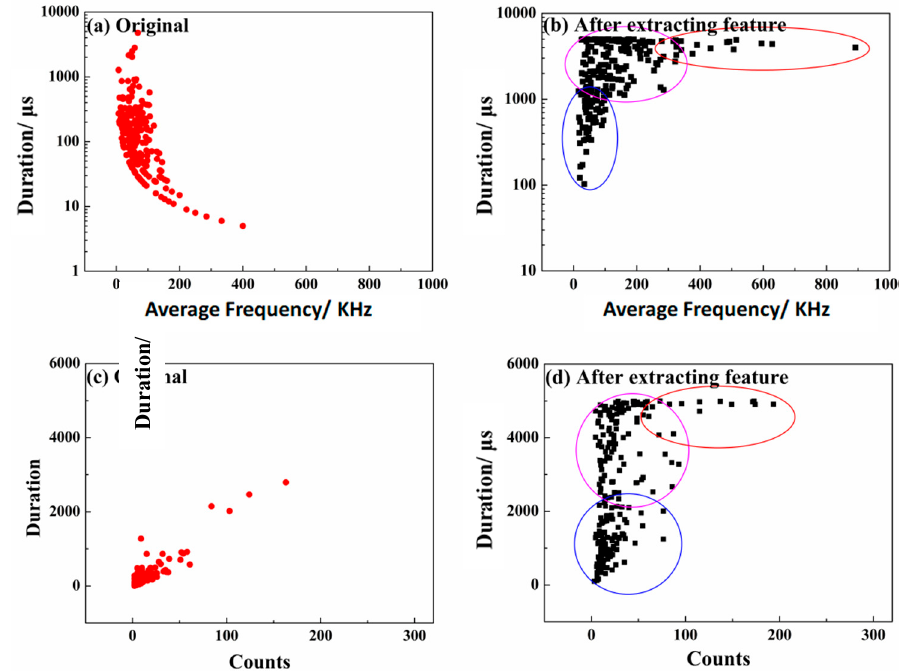
Figure 8. Analysis of the parameters of the signals of Q235 carbon steel in 2000 mg/L NaHCO 3 + 800 mg/L NaCl: ( a ) and ( c ) original relationship of the duration-average frequency and duration-counts, ( b ) and ( d ) relationship of the duration-average frequency and duration-counts after the extracting feature.